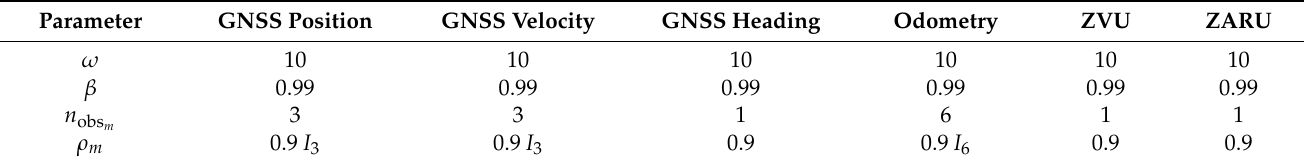
Table 3. Parameters for Kalman Integrated Protection Level (KIPL) integrity algorithm.